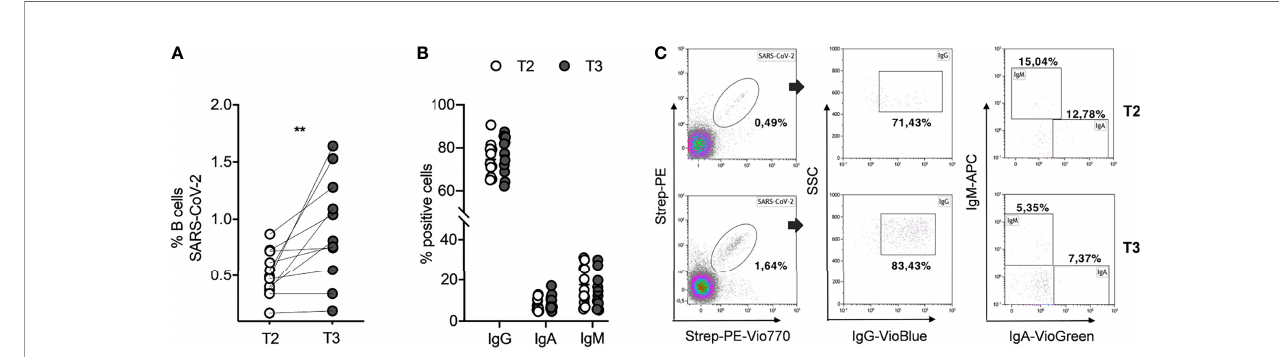
FIGURE 2 | SARS-CoV-2-speci fi c memory B cells in seronegative recipients (ICs n=11) of P fi zer-BioNTech BNT162b2 mRNA-based vaccination before (T2) and after (T3) the booster dose. (A) Percentage (%) of SARS-CoV-2 speci fi c B cells before and after the booster dose. (B) Comparison amid T2 and T3 of percentage (%) positive cell to surface immunoglobulin isotypes, IgG, IgA, and IgM. (C) Representative fl ow cytometry plots (one subject) showing memory B-cell subpopulations. The signi fi cance was determined using Wilcoxon matched-pairs test (A) and Sidak ’ s multiple comparisons test (B) , one-way